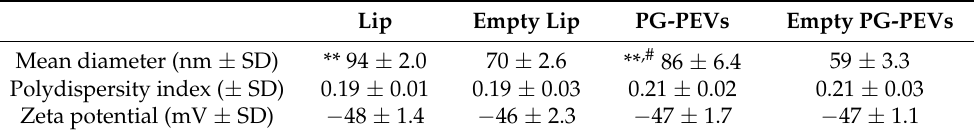
Table 5. Characteristics of P. spinosa fruit extract nanoformulations. Each value represents the mean ± standard deviation (SD); n > 10.